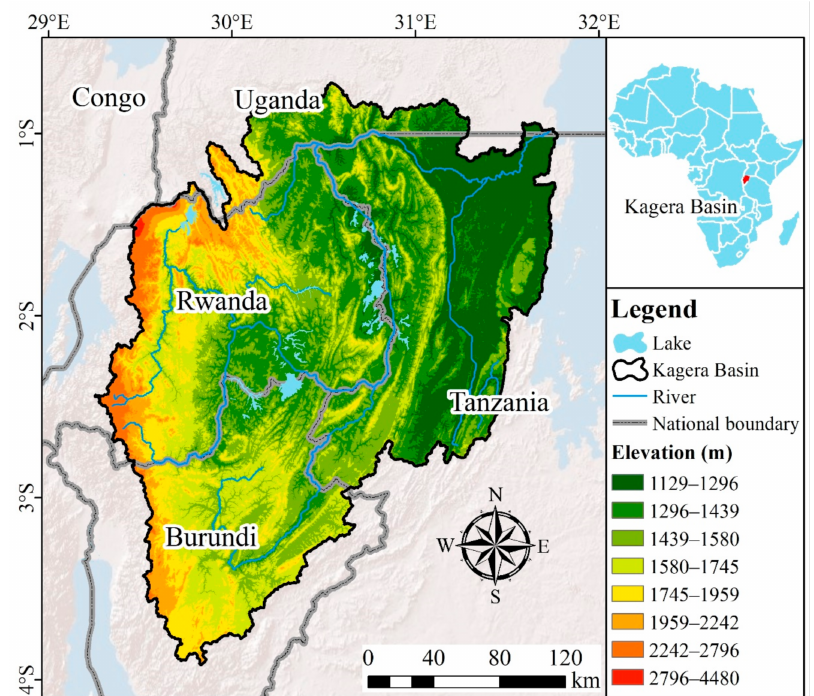
Figure 1. Location of the study